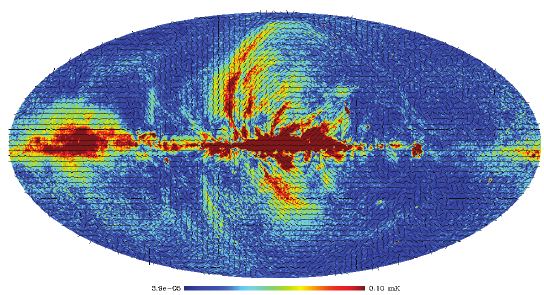
Figure 4. All-sky map in Galactic coordinates (with the Galactic center in the middle) of the polarized intensity of the 23GHz continuum emission measured by WMAP, with the polarization half-vectors rotated by 90 ◦ to trace the orientation of credit: Tess Ja ff e.